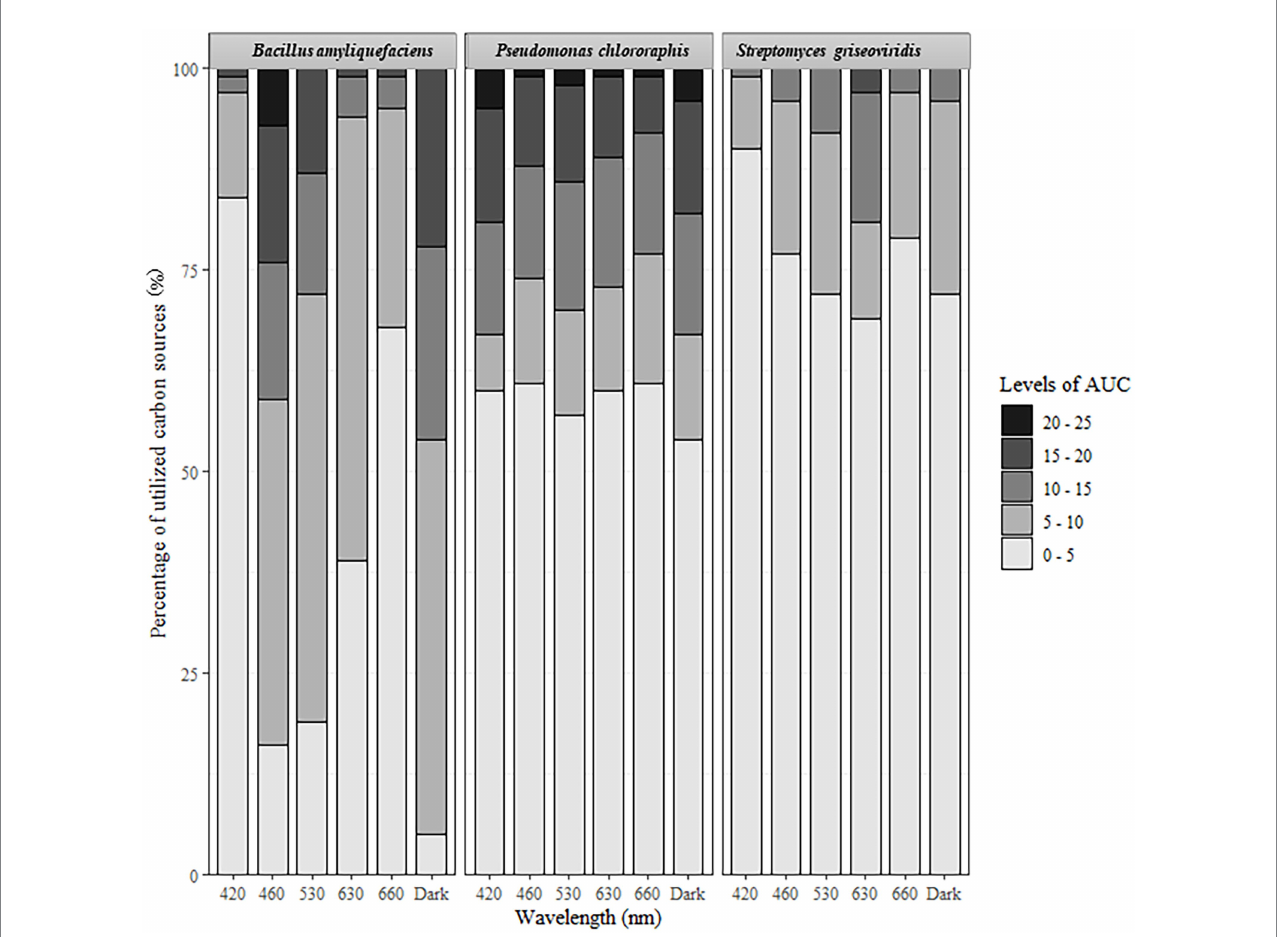
FIGURE 2 Percentage of carbon sources utilized under different light regimes. Area under the curve (AUC) values ranged from 0 to